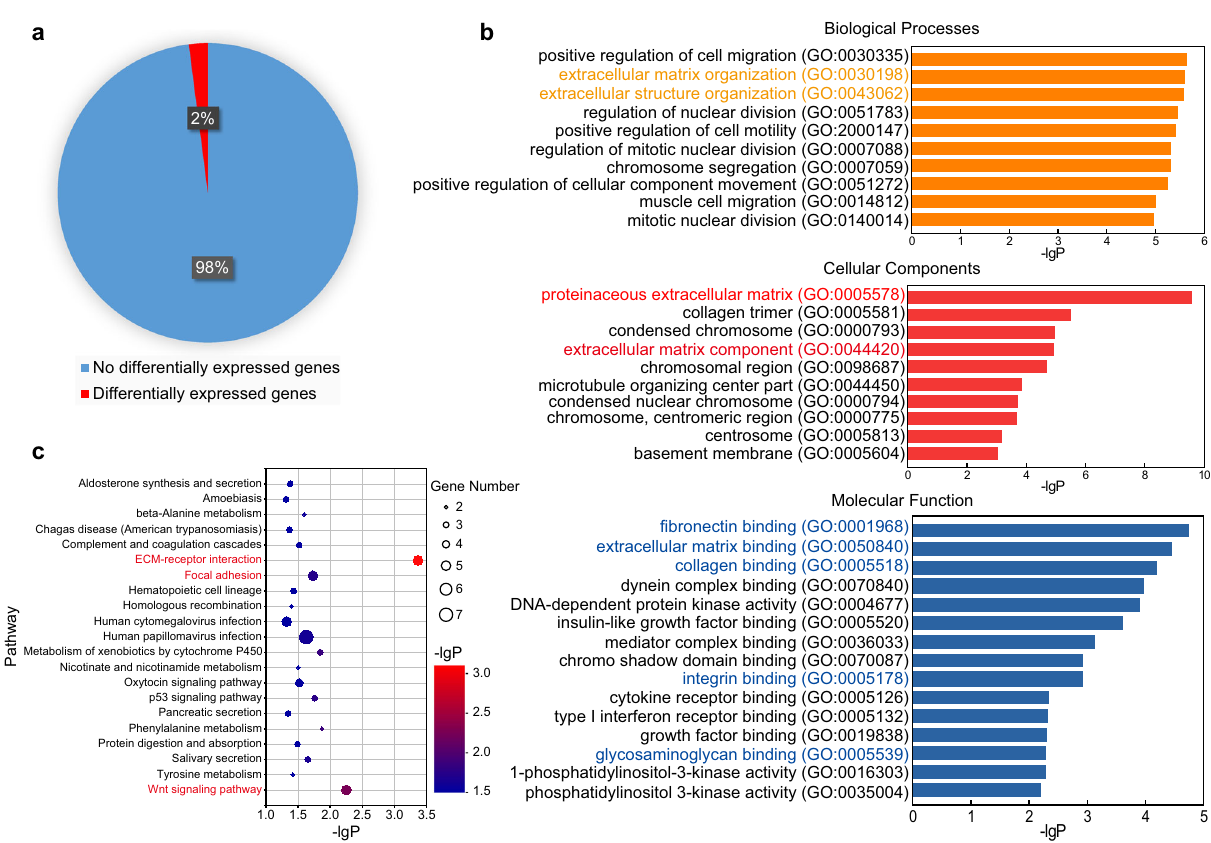
Fig. 3 RNA-seq analysis on DM 50 CO 50 -modi fi ed surface compared to RGD-modi fi ed surface. a From 17,267 gene transcripts in analysis, 305 differentially expressed genes showed greater than 50% change in expression level after 2 days of culture. b Signi fi cant GO terms of associated biological processes, cellular components, and molecular functions from differentially regulated genes. c KEGG pathway enrichment. The y -axis label represents KEGG pathway, and the x -axis shows -lgP. The size of the dots represents the number of gene